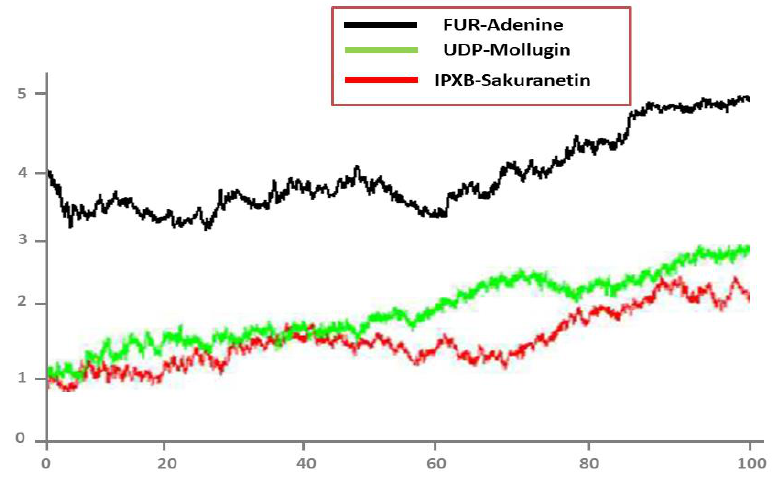
Figure 6. RMSD analysis of top docked complexes.